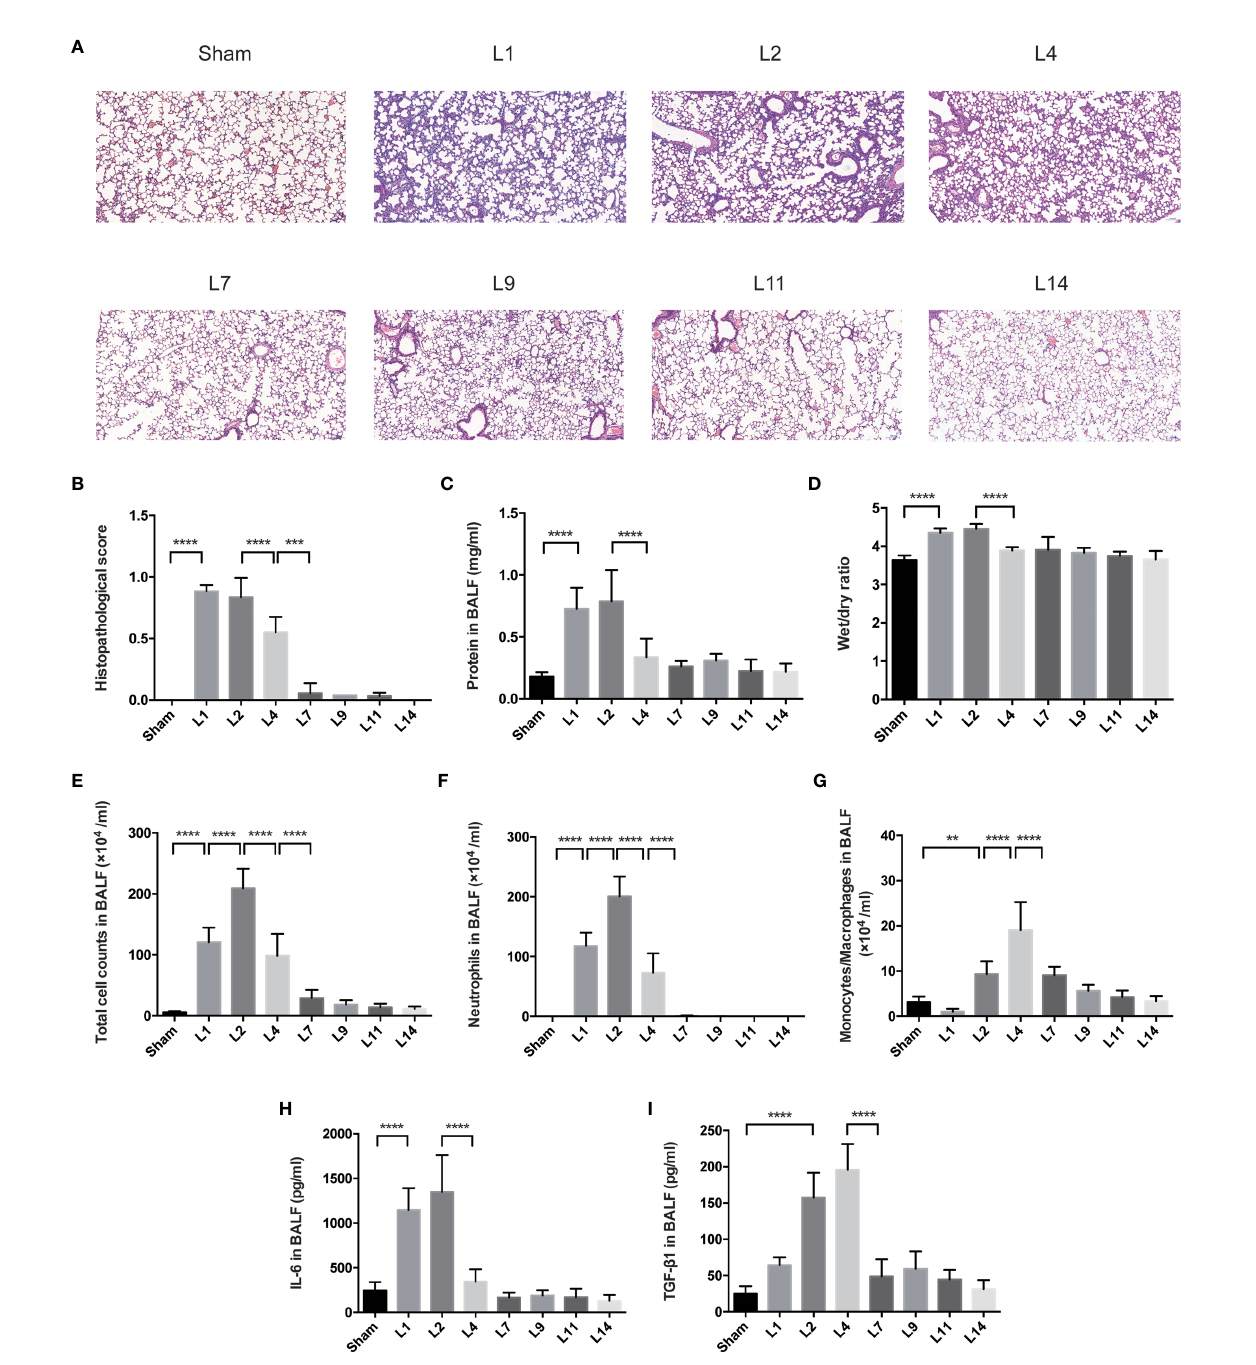
FIGURE 1 | Lung injury exhibited a dynamic variation within 2 weeks during LPS-induced ARDS. (A) Histopathological staining. Representative HE staining of lung sections are shown 1, 2, 4, 7, 9, 11, 14 days after LPS-induced ARDS. Original magni fi cation = 100×, scale bar represents 100 m m. (B) Histopathological scores of (A) . Lung injury was evaluated on a scale of 0 – 2 for each of the following criteria: i) neutrophils in the alveolar space; ii) neutrophils in the interstitial space; iii) hyaline membranes; iv) proteinaceous debris; v) alveolar septal thickening. The fi nal histopathological scores was as follows: score = [20*(i)+14*(ii)+7*(iii)+7*(iv)+2*(v)]/(number of fi elds *100) (C) The protein in BALF. (D) The wet/dry ratio of lung tissue. (E) Total cell counts in BALF. (F) Neutrophils in BALF. (G) Monocytes/Macrophages in BALF. (H) Secretion of cytokine IL-6 in BALF. (I) Secretion of cytokine TGF- b 1 in BALF. For all panels: mean ± S.D. **p ≤ 0.01; ***p ≤ 0.001; and ****p ≤ 0.0001 for one-way analysis of variance with the Bonferroni post hoc test for multiple t-tests. A value of p < 0.05 was considered statistically signi fi cant. n = 6 – 8 mice per